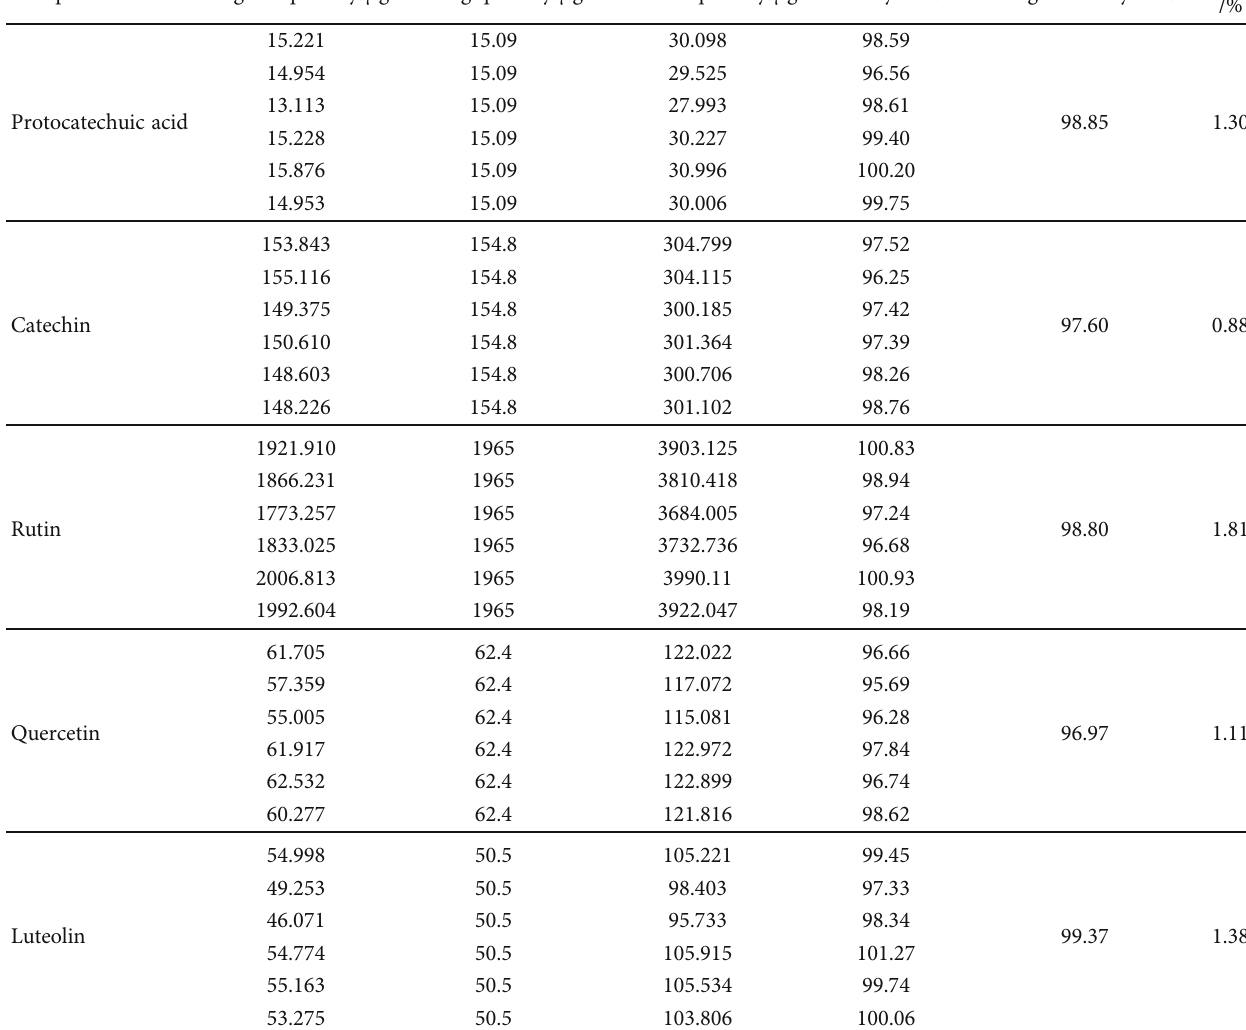
Table 3: Results of sample recovery of each